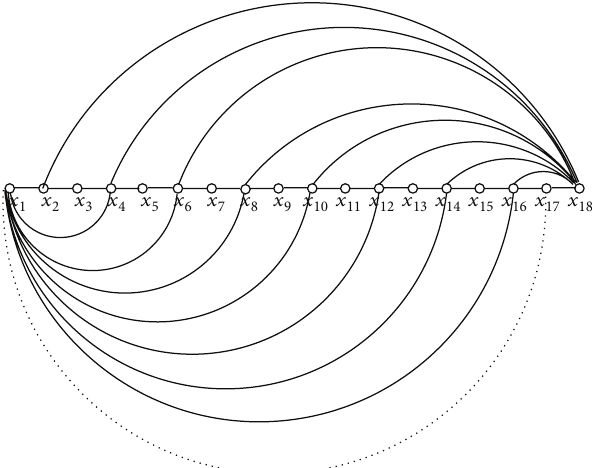
Figure 3: Config-2: 𝑘 is even (the dotted edge is nonexistent).